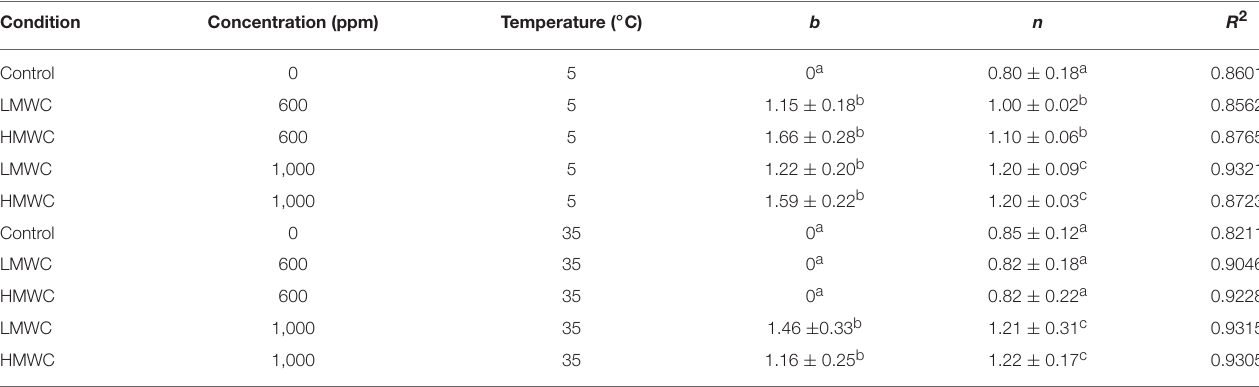
TABLE 1 | Weibull model parameters + (mean ± standard deviation) for V. cholerae Non-01 growth or inhibition curves subjected to selected concentrations of low or high molecular weight chitosan at different temperatures.